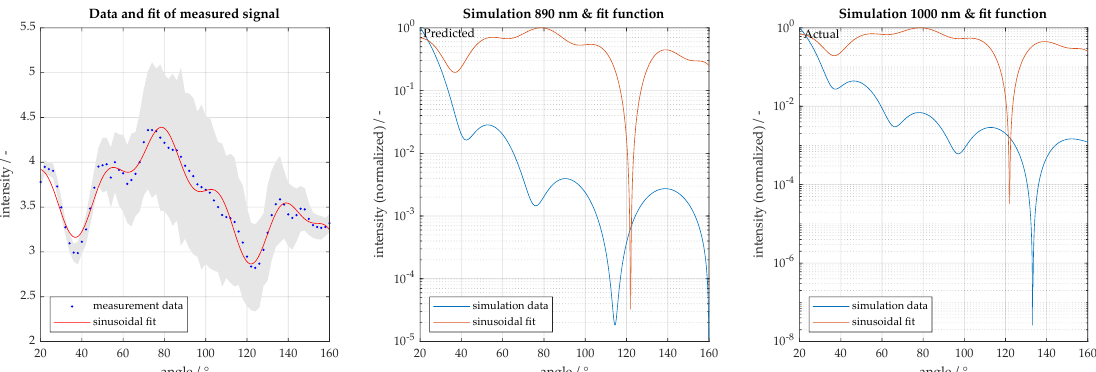
Figure 9. Particle size characterization for 1000 nm polystyrene particles. Light scatter measured in 2 ◦